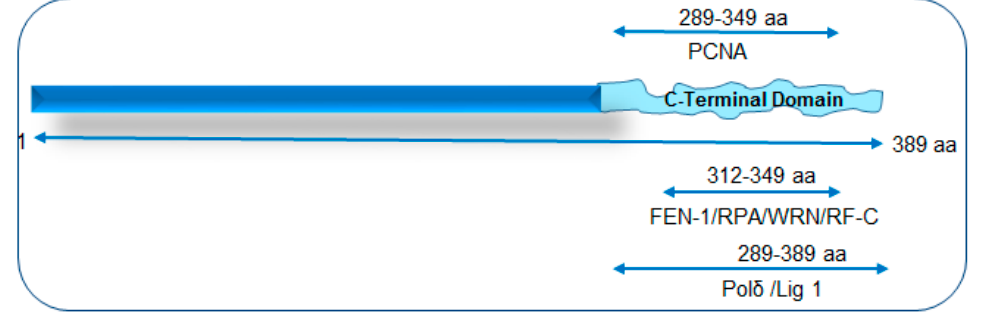
Figure 1. A schematic of NEIL1’s interaction mapping with long patch-base excision repair (LP-BER)/replication proteins to its disordered C-terminal domain. PCNA: proliferating cell nuclear antigen; FEN-1: flap endonuclease 1; RPA: replication protein A; WRN: Werner helicase; RF-C: replication factor C; Pol δ : polymerase delta; Lig 1: ligase 1.